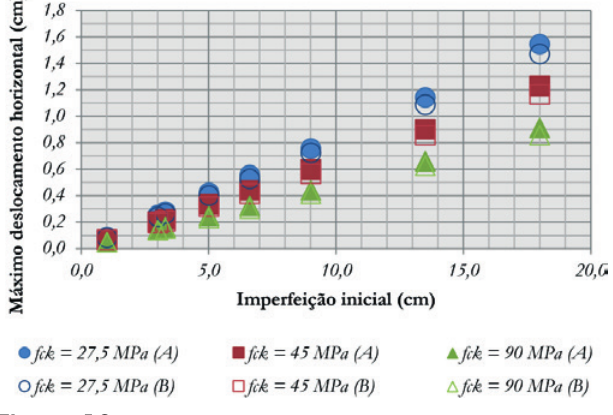
Máximos deslocamentos horizontais